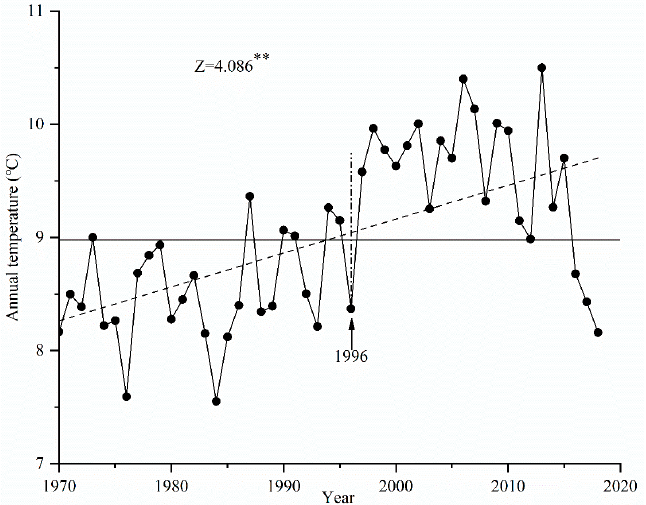
Figure 6. Observed annual average temperature in the Beiluo River Basin. Horizontal solid line in ‐ dicates the mean values, dotted line represents the trend line and vertical long dotted line presents the abrupt point year. Z statistic could be derived from the M–K trend test (** 0.01 p ＜